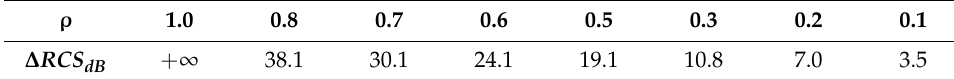
Table A1. Maximum target RCS variation due to multipath.